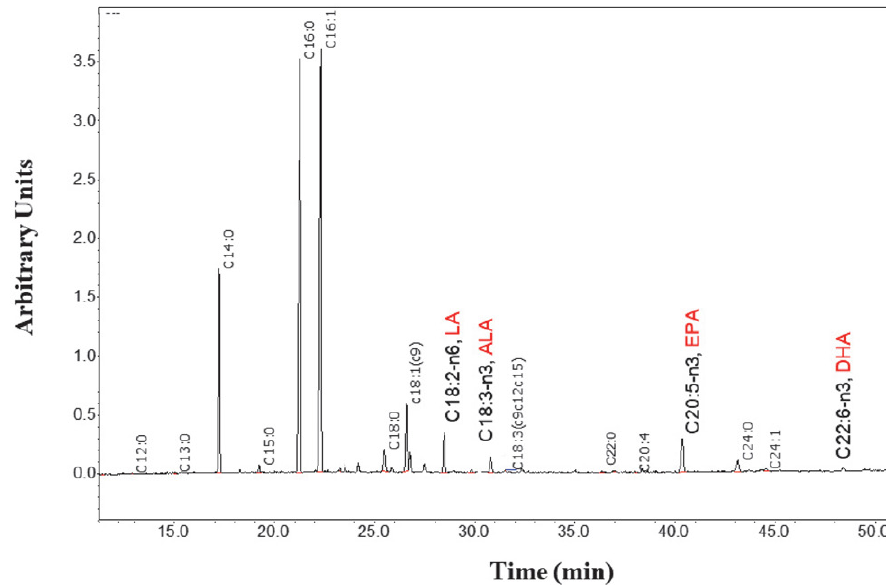
Fig. 2. Representative chromatogram of fatty acids profile present in P. tricornutum. Note: the method used was M5 (alkali